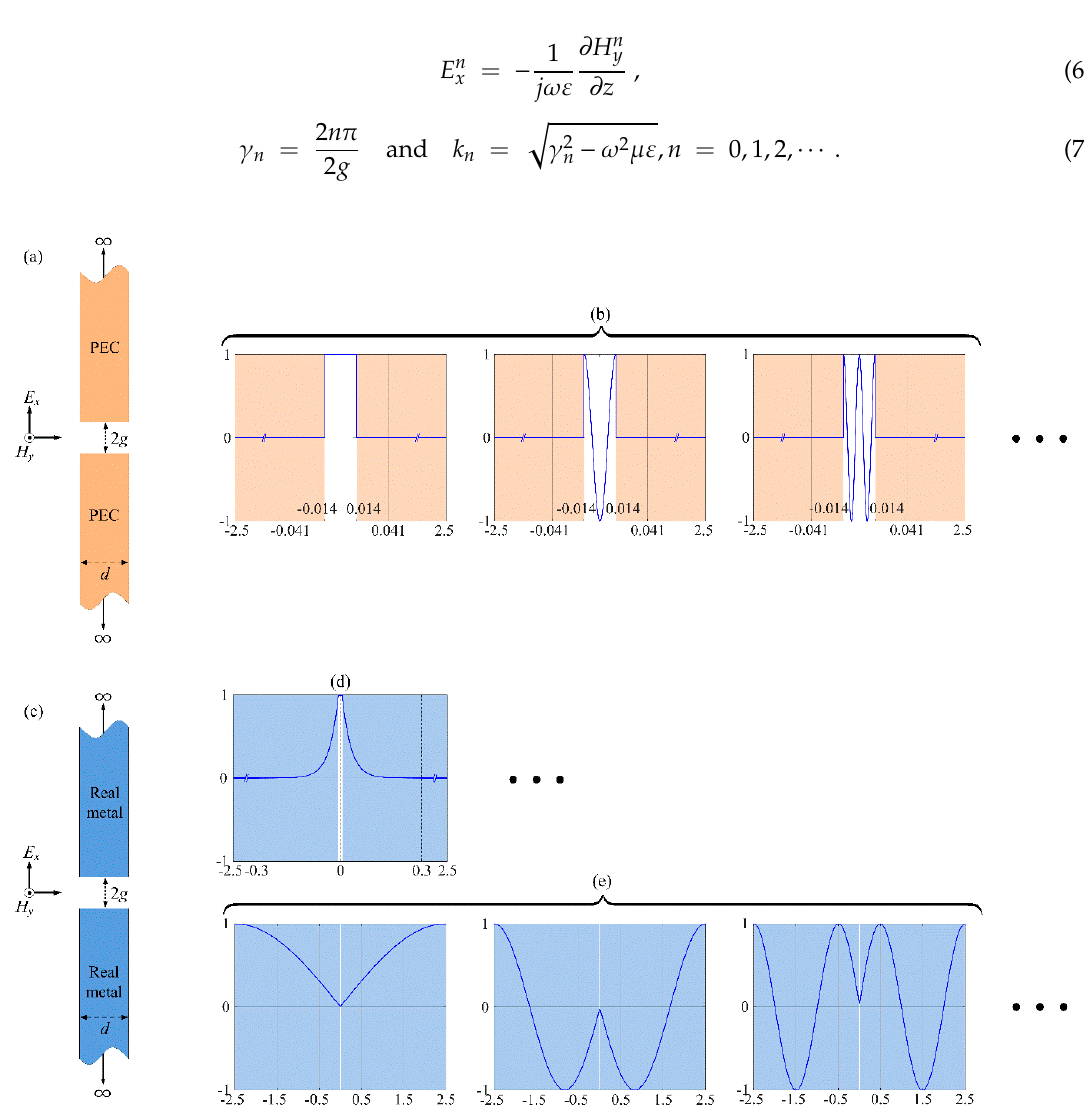
Figure 4. Geometries of di ff erent metal–insulator–metal (MIM) waveguides for gap width 2 g = 8 nm, when a transverse magnetic (TM) polarized electromagnetic wave is normally incident: ( a ) a PEC as the conducting material in the MIM waveguide and ( b ) the corresponding field profiles of the guided modes (transverse electromagnetic (TEM), TM 2 , and TM 4 modes); ( c ) a practical metal as the conducting material in the MIM waveguide, such as silver and the corresponding field profiles for a point spectrum (PS) ( d ) and a discretized continuous spectrum (DCS) ( e ). Note that di ff erent scales are shown within the periods of ( b , d